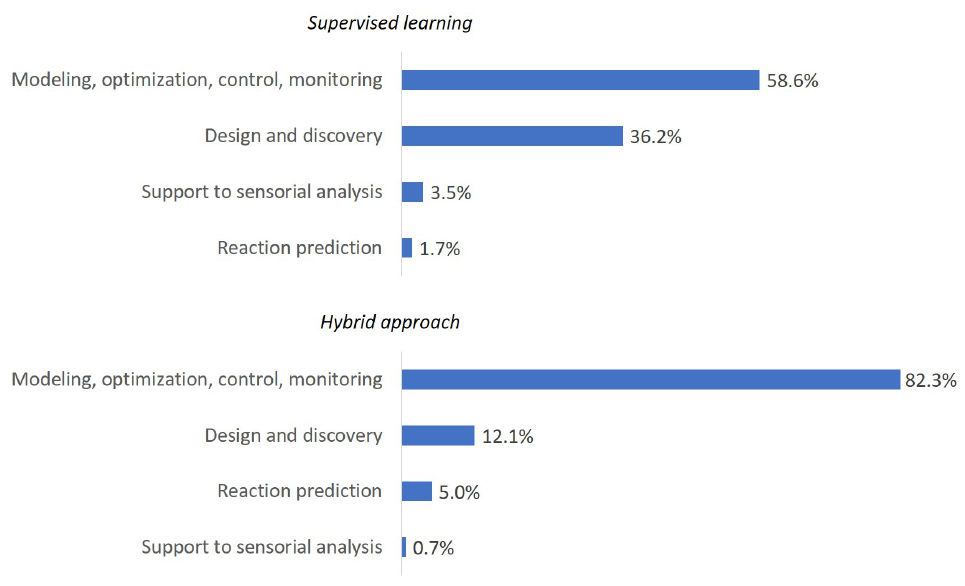
Figure 7. Distribution of CPE problem types in the reviewed ML applications. ( top ) For supervised learning methods. ( bottom ) For hybrid